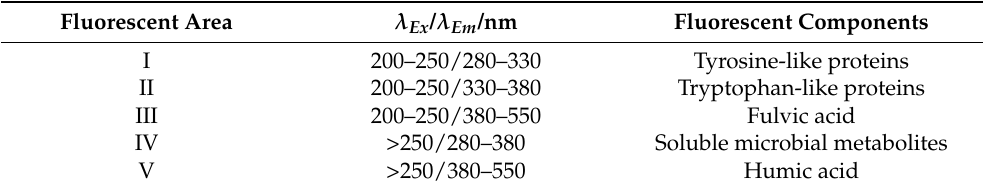
Table 4. Characteristics of fluorescent peak regions in three-dimensional fluorescence spectra of dissolved organic